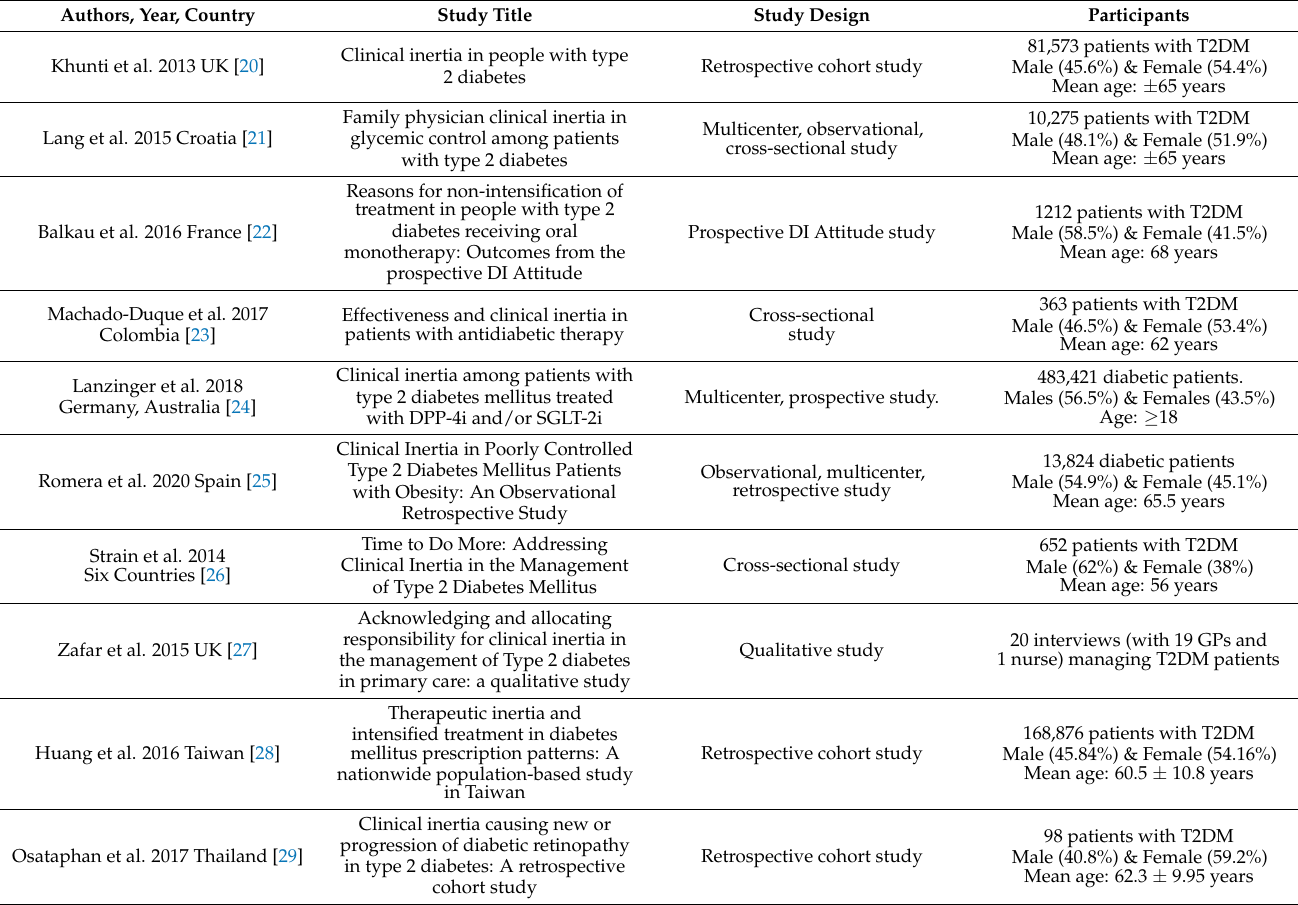
Table 4. List of studies included in this